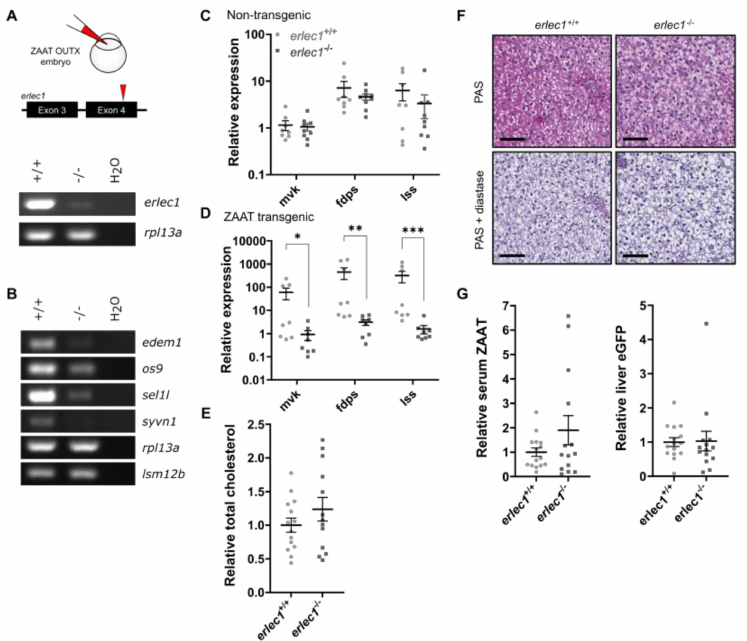
Figure 6. Erlec1 ablation further suppresses cholesterol biosynthesis in ZAAT-expressing zebrafish liver. ( A ) gRNA targeting exon 4 was injected into embryos from the Tg( lfabp : eGFP-T2A-ZAAT) line at the one-cell stage. RT-PCR for erlec1 used cDNA made from 1 µ g RNA extracted from pooled whole embryos at 7 dpf. The housekeeping gene rpl13a was used as a loading control. ( B ) RT-PCR of genes encoding components of Hrd1 E3 ligase complex using cDNA made from 1 µ g RNA extracted from adult zebrafish liver. The housekeeping genes rpl13a and lsm12b were used as loading controls. qPCR analysis of representative cholesterol biosynthesis DEGs in adult ( C ) non-transgenic zebrafish livers, as well as ( D ) livers expressing ZAAT, using data pooled from two independent experiments. Expression values were normalised to the housekeeping genes fabp10a , rpl13a, and lsm12b . Error bars indicate mean ± s.e.m. Unpaired student’s t -test and Mann-Whitney U test were used to detect statistical significance for each gene. * p < 0.05, ** p < 0.01, *** p < 0.001. ( E ) Total cholesterol was measured in adult ZAAT-expressing livers ( erlec1 +/+ , n = 14, erlec1 − / − , n = 13). Every single point represents the average of two technical replicate measurements for each animal. Student’s t -test was performed and indicated no significant difference in levels from wildtype and erlec1 − / − fish. ( F ) Periodic acid-Schiff (PAS) staining with and without diastase was performed on 3 µ m thick paraffin zebrafish liver sections. The scale bar represents 50 µ m. ( G ) The ratio of antitrypsin to IgM (left panel) and eGFP to total protein (right panel) in zebrafish blood was detected by immunoblot (see Supplementary Figure S10) and quantitated by densitometry. Shown are the pooled data from four independent experiments, with each point representing an individual fish. Student’s t -test was performed and indicated no significant difference between levels in wildtype and erlec1 − / −